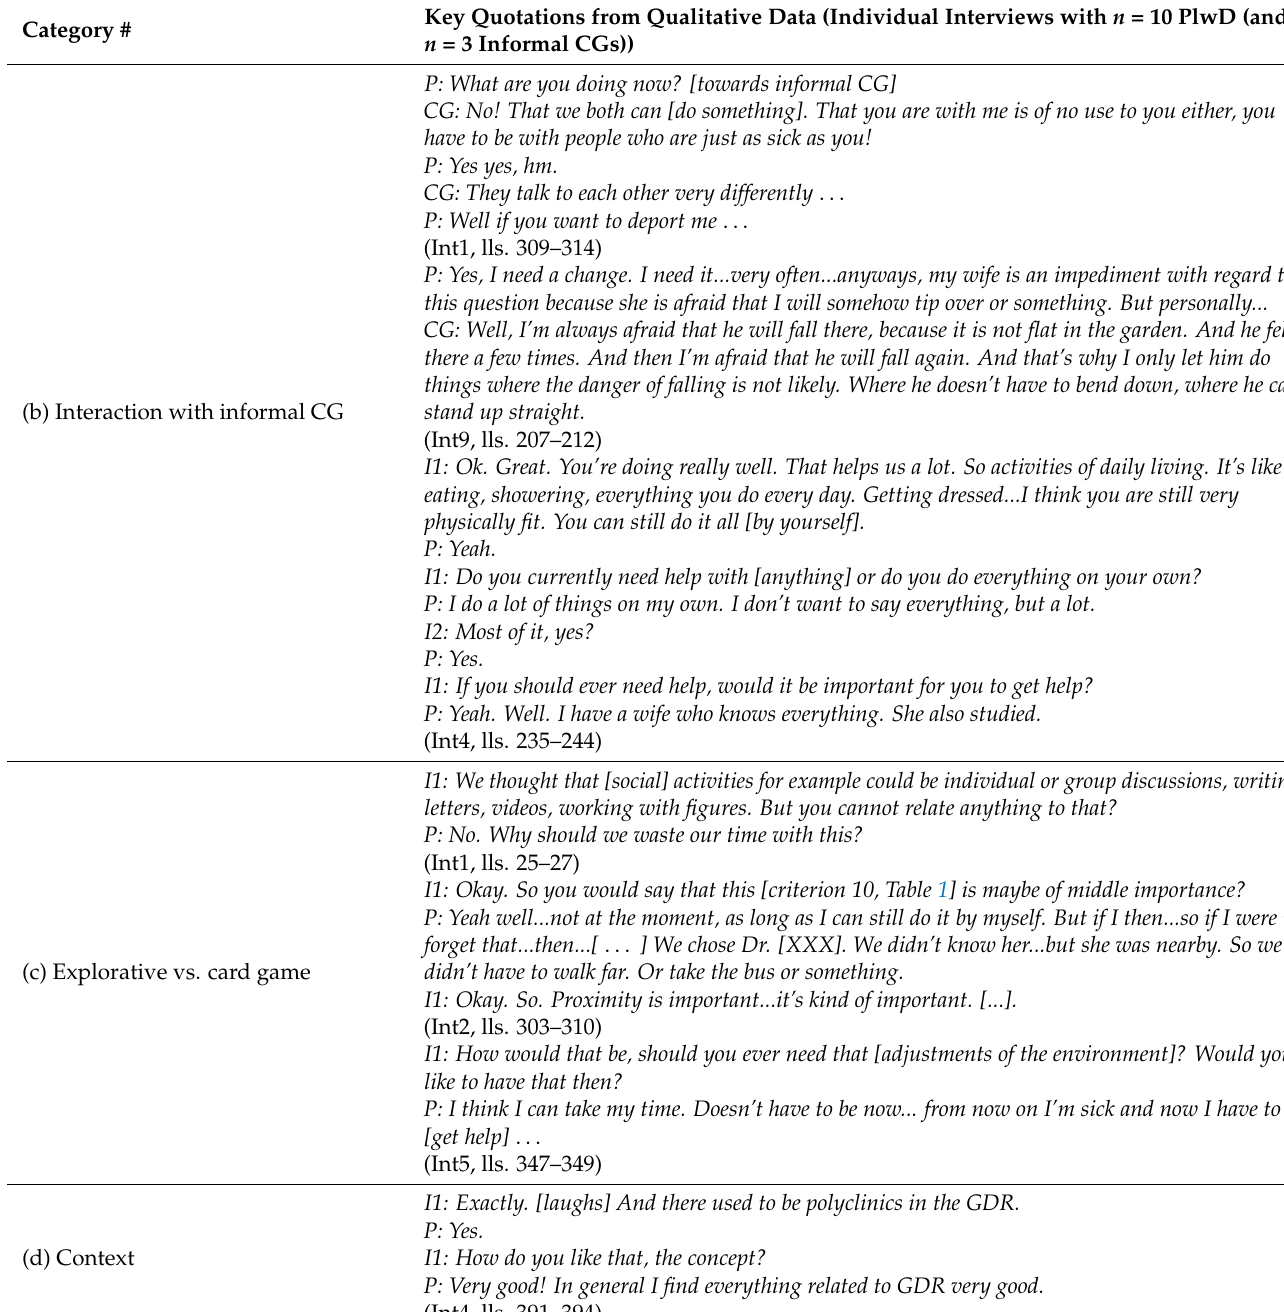
Table 4. Cont. Key Quotations from Qualitative Data (Individual Interviews with n = 10 PlwD (and n = 3 Informal